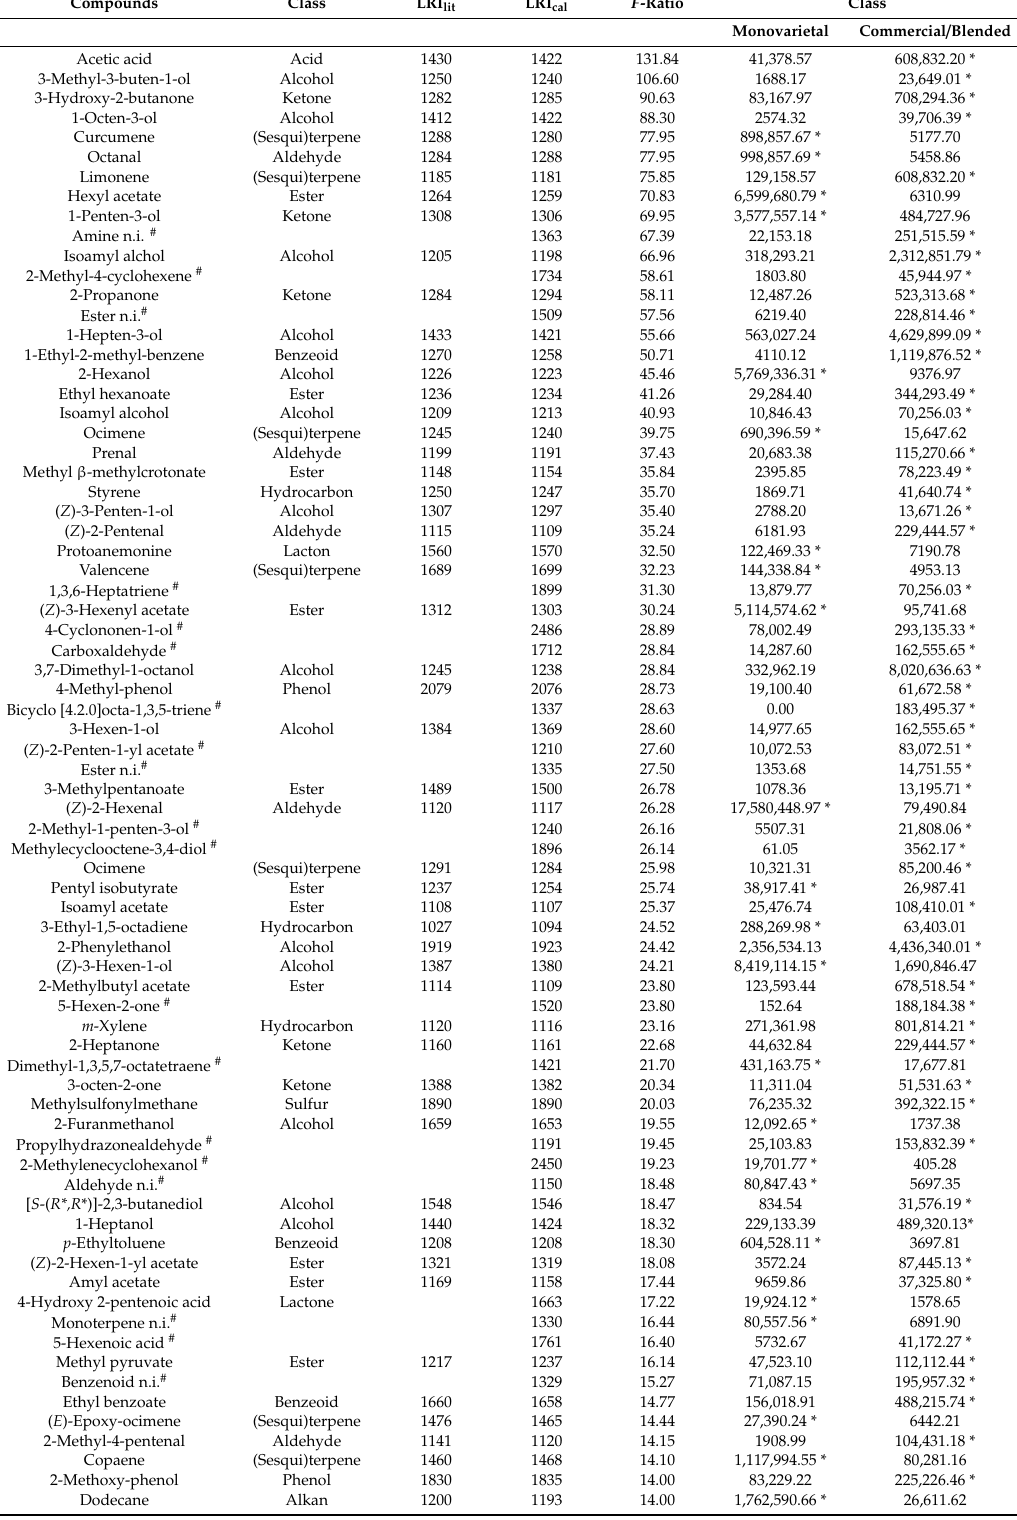
Table 2. List of volatile aroma compounds found in monovarietal Protected Designation of Origin (PDO) and commercial-blended extra virgin olive oils by headspace solid-phase microextraction combined with comprehensive two-dimensional gas chromatography-mass spectrometry (HS-SPME-GC × GC-TOF-MS) sorted by descending Fisher F -ratio, compound class, retention index (monodimensional column), and semi-quantitative values in µ g / kg relative to internal